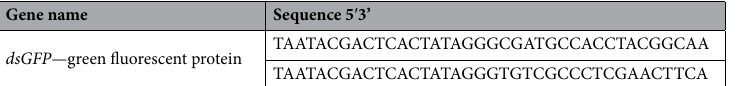
Table 3. Green fluorescent protein dsRNA forward and reverse primers, with T7 promoter